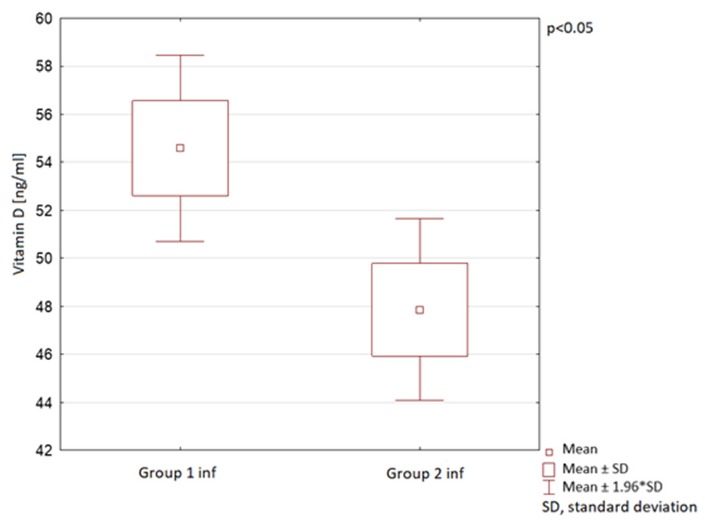
Figure 5. Vitamin D serum levels in children under 1 year of age in the compared groups. The vitamin D serum levels were also analysed in the course of different year seasons. In spring, summer, and autumn, the mean vitamin D serum levels in Group 2 were observed to be significantly lower than in Group 1. In winter, no statistically significant difference between the groups was observed (Table 1; Figures 6–8). Table 1. Mean vitamin D serum level according to year seasons in the compared groups.